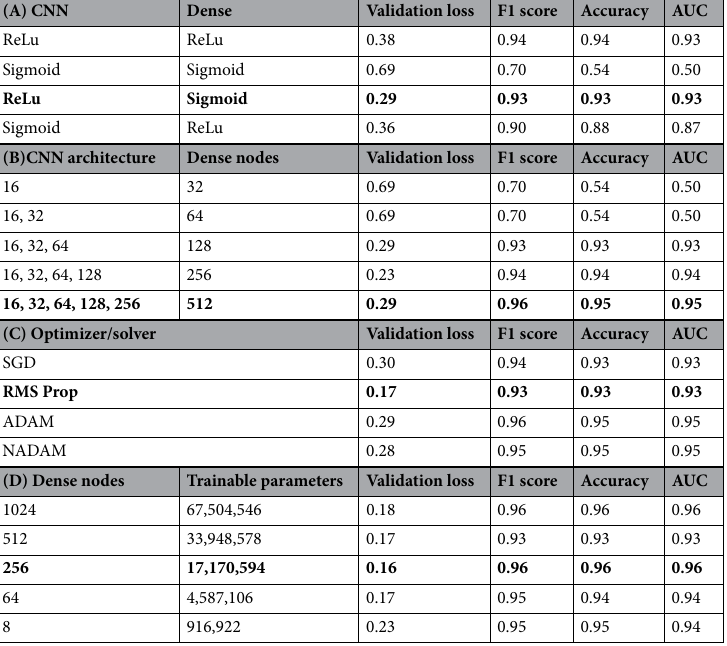
Table 2. Summary of performance metrics for stepwise optimization steps. Average validation loss for the final 5 epochs during model training and F1 scores calculated from model predictions on gelatin phantom image sets are shown for four model optimization parameters: (A) Layer activators for the 2D CNN and 1D Dense neural network layers, (B) 2D CNN layer architecture, (C) model optimizer, and (D) total number of trainable parameters. Bold text font in each table region represents the selected model architecture that was used for subsequent optimization